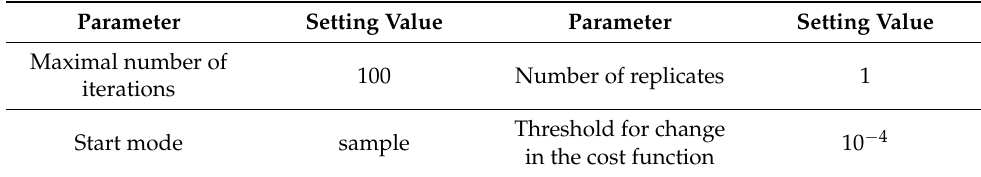
Table 1. Parameter settings of k-means++.